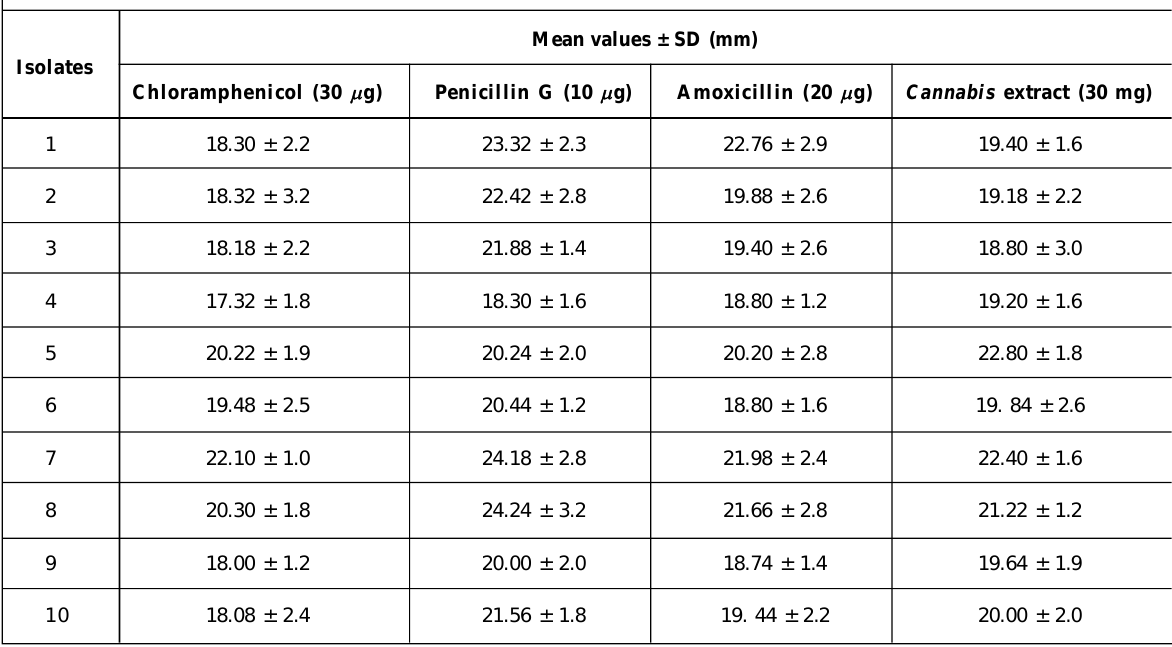
Table 2: Zones of inhibition of Cannabis extracts and antibiotics against Streptococcus